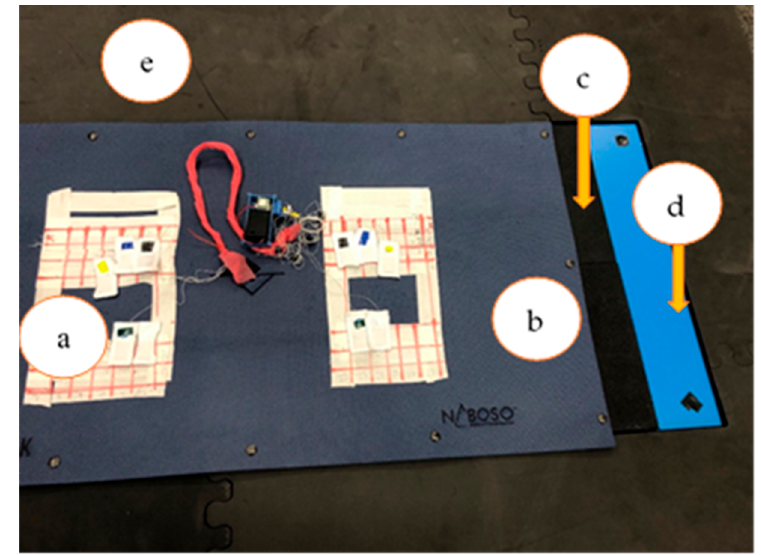
Figure 1. Testing platform consisting of: ( a ) ten C-SRSs, ( b ) BodiTrak TM Vector Plate, ( c ) rubber flooring, ( d ) Kistler TM Force Plates, and ( e ) foam force plate surround.